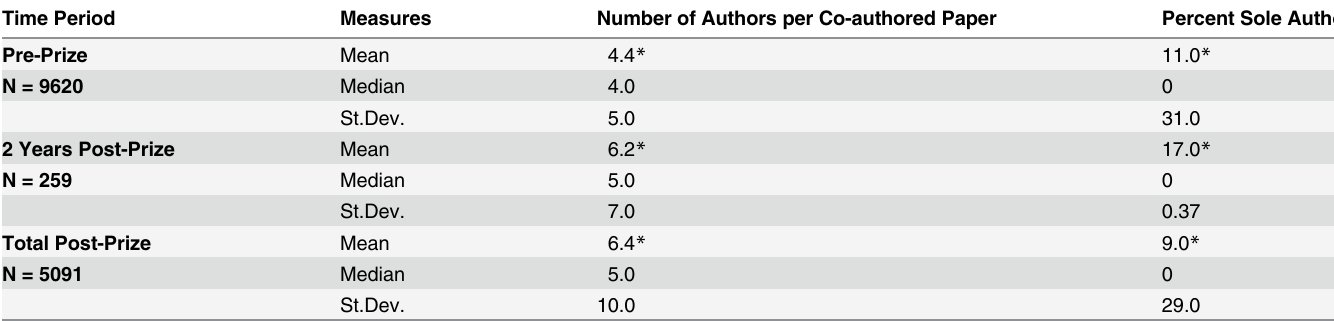
Table 3. The Effect of the Prize on Laureates ’ Authorship